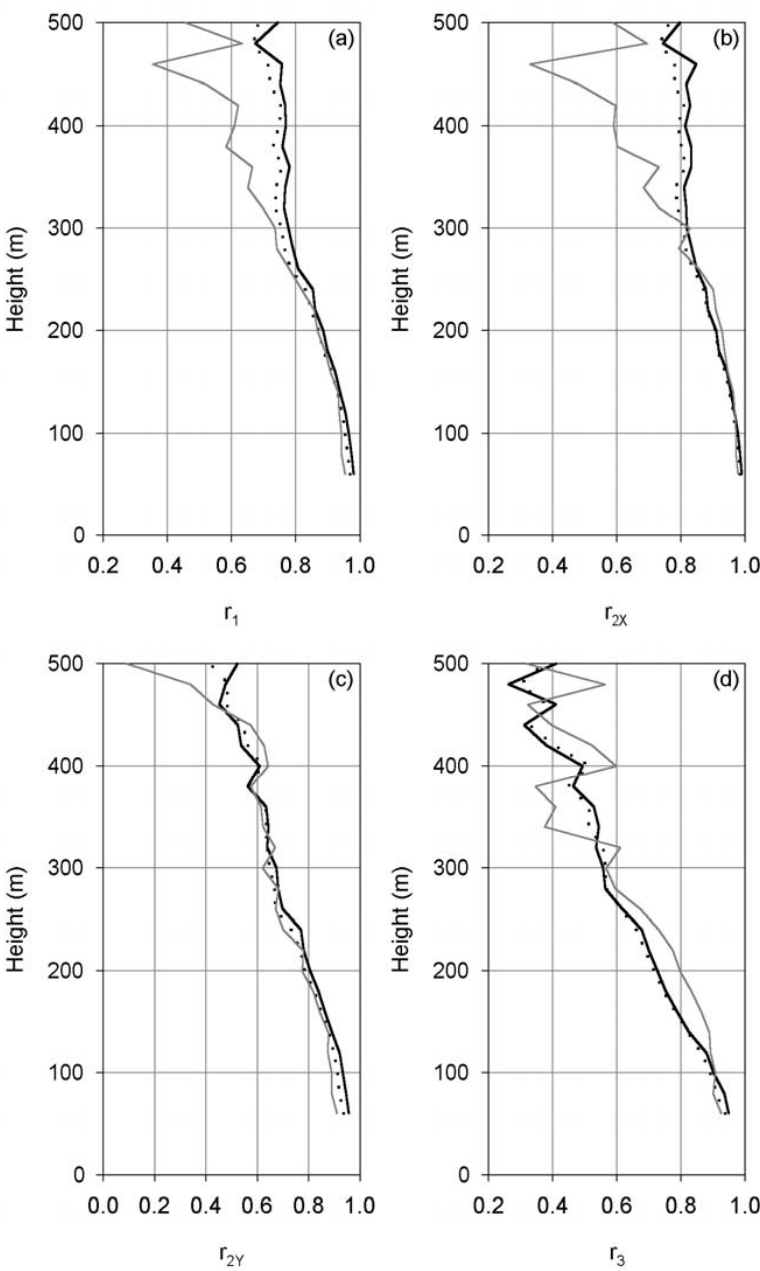
Fig. 13. Correlation coefficients calculated for the three methods considered above: (a) vector correlation, (b) and (c) correlation of wind components and (d) scalar correlation, dotted line for the global data, in black for the night and in grey for the day.